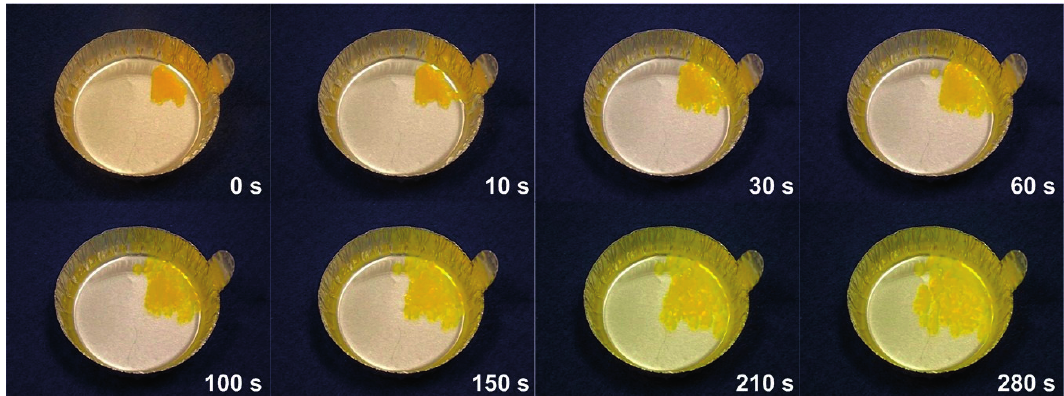
Figure 23 . Snapshot of the disassembly process in the first 280